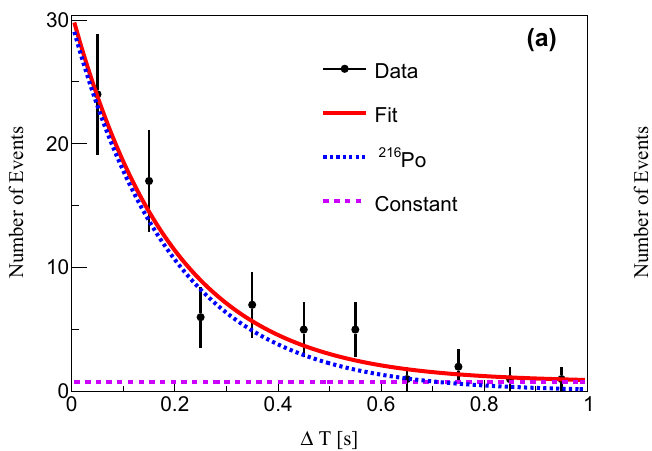
Fig. 11 Time difference ( (cid:10) T) distributions of data (points) and expo- nential fits (red solid line) between two successive α -induced events are presented. Here, decay time used in the fit is fixed to the known lifetime of each radioisotope. a 216 Po → 212 Pb (half-life of 0.145s) events are extracted from the fit including an exponential component of the 216 Po (bluedottedline)andrandomcoincidence(purpledashedline)events. b